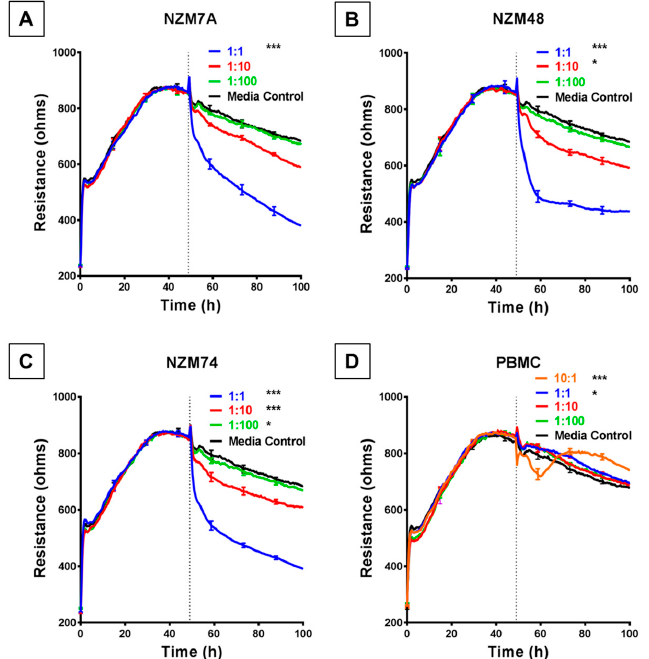
Figure 2. ECIS reveals decreases in hCMVEC barrier resistance following exposure to NZM melanoma cells. ( A – C ) Unmodelled resistance (at 4000 Hz) of hCMVECs over time after addition of three di ff erent NZM cell lines. Cells were added at di ff erent e ff ector:target (E:T) ratios, where 1:1 shows 1 NZM